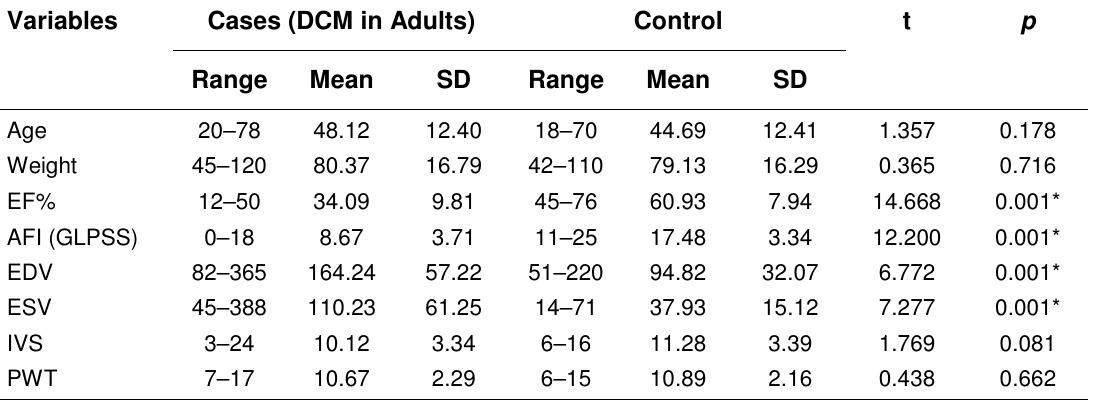
Comparison of Measured Variable in Relation to Studied Groups (Adults with DCM vs.